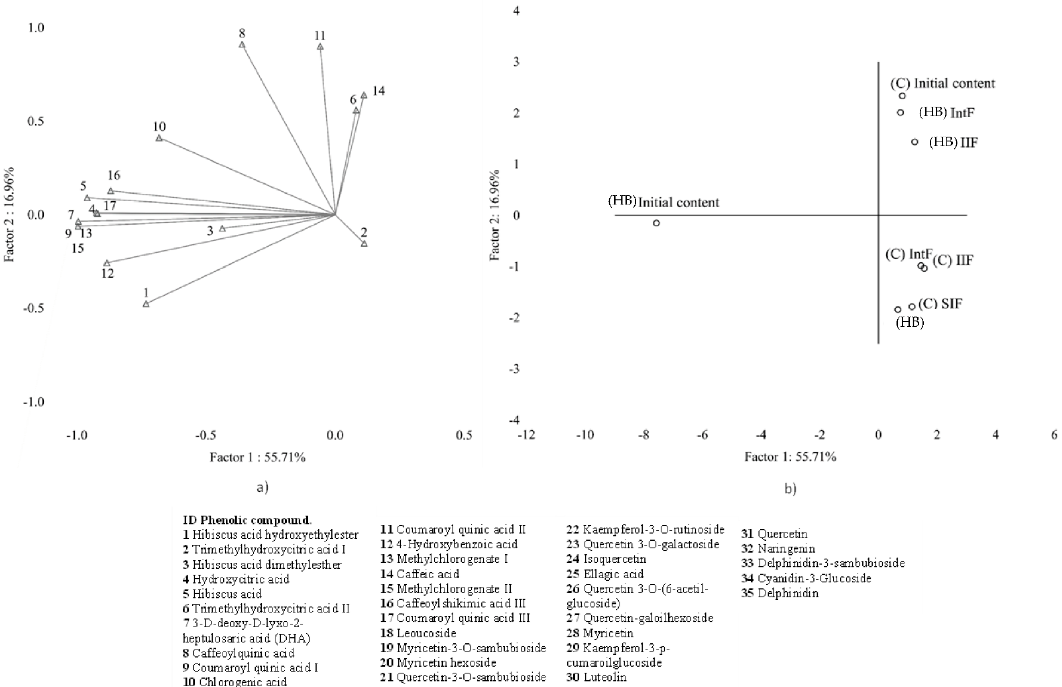
Figure 1. Analysis of phenolic acids patterns by group found in the extracts from “initial content” and during in vitro gastrointestinal digestion of commercial (C) and Hibiscus beverage (HB) using principal component analysis (PCA): ( a ) Projection of the variables on the factor-plane, ( b ) projection of the cases on the factor-plane.